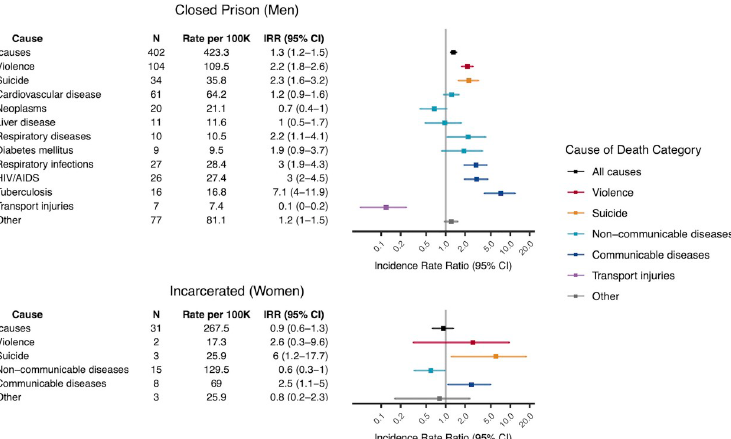
Fig 3. Age-standardized mortality rates among incarcerated men and women. All-cause and cause-specific mortality rates and IRRs for the leading causes of death among incarcerated men in closed prisons and for broad causes of death among incarcerated women in any facility type. Rates were directly standardized to the age structure for incarcerated men or women. IRRs were computed relative to non-incarcerated male or female Mato Grosso do Sul residents. Colors correspond to broad cause of death categories. Within each category, causes are ordered by number of deaths. A total of 17 deaths of men in closed prisons and 2 deaths of incarcerated women were excluded due to missing age information. 100K, 100,000 person-years; IRR, incidence rate ratio; N , number of deaths.